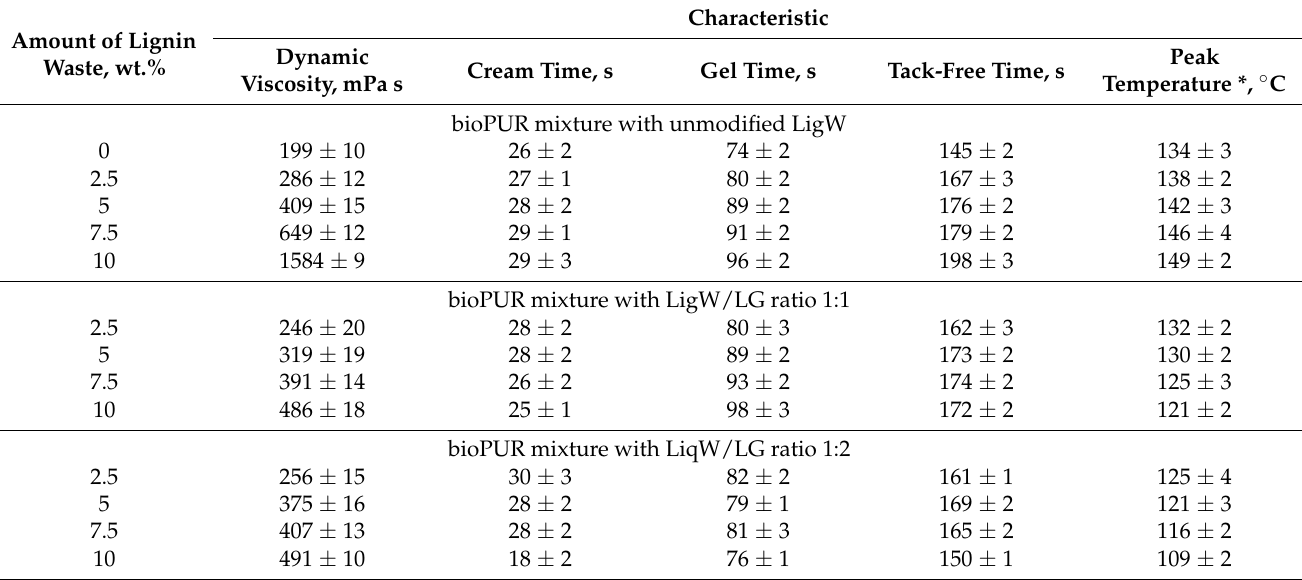
Table 3. Foaming parameters and characteristics of polyol